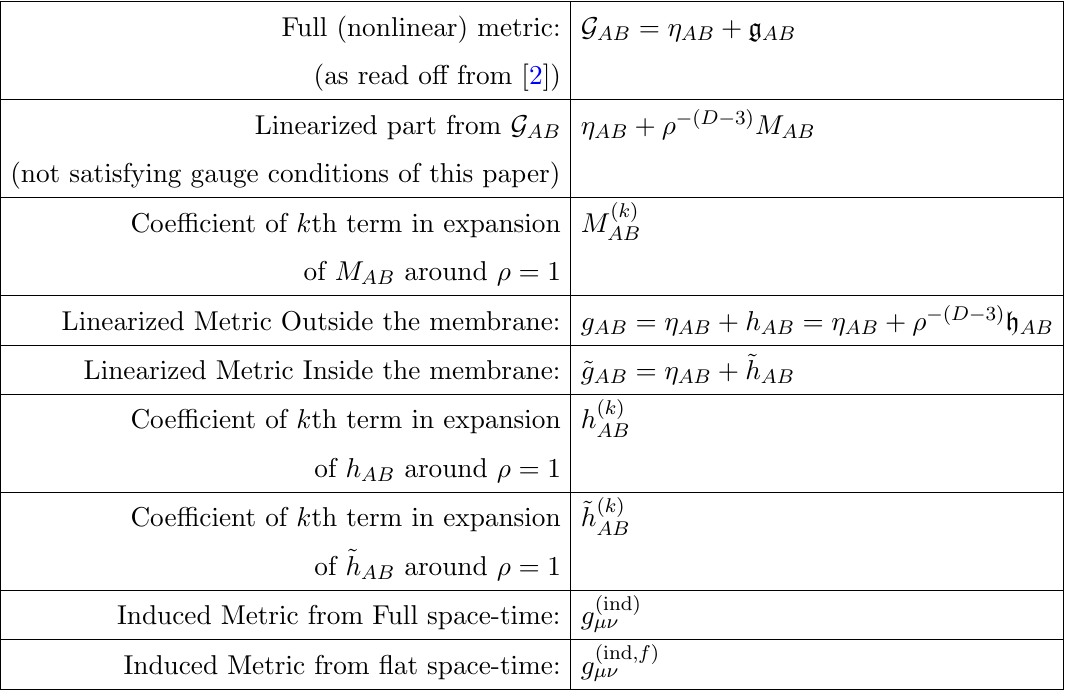
Table 4 . Di(cid:11)erent metrics.